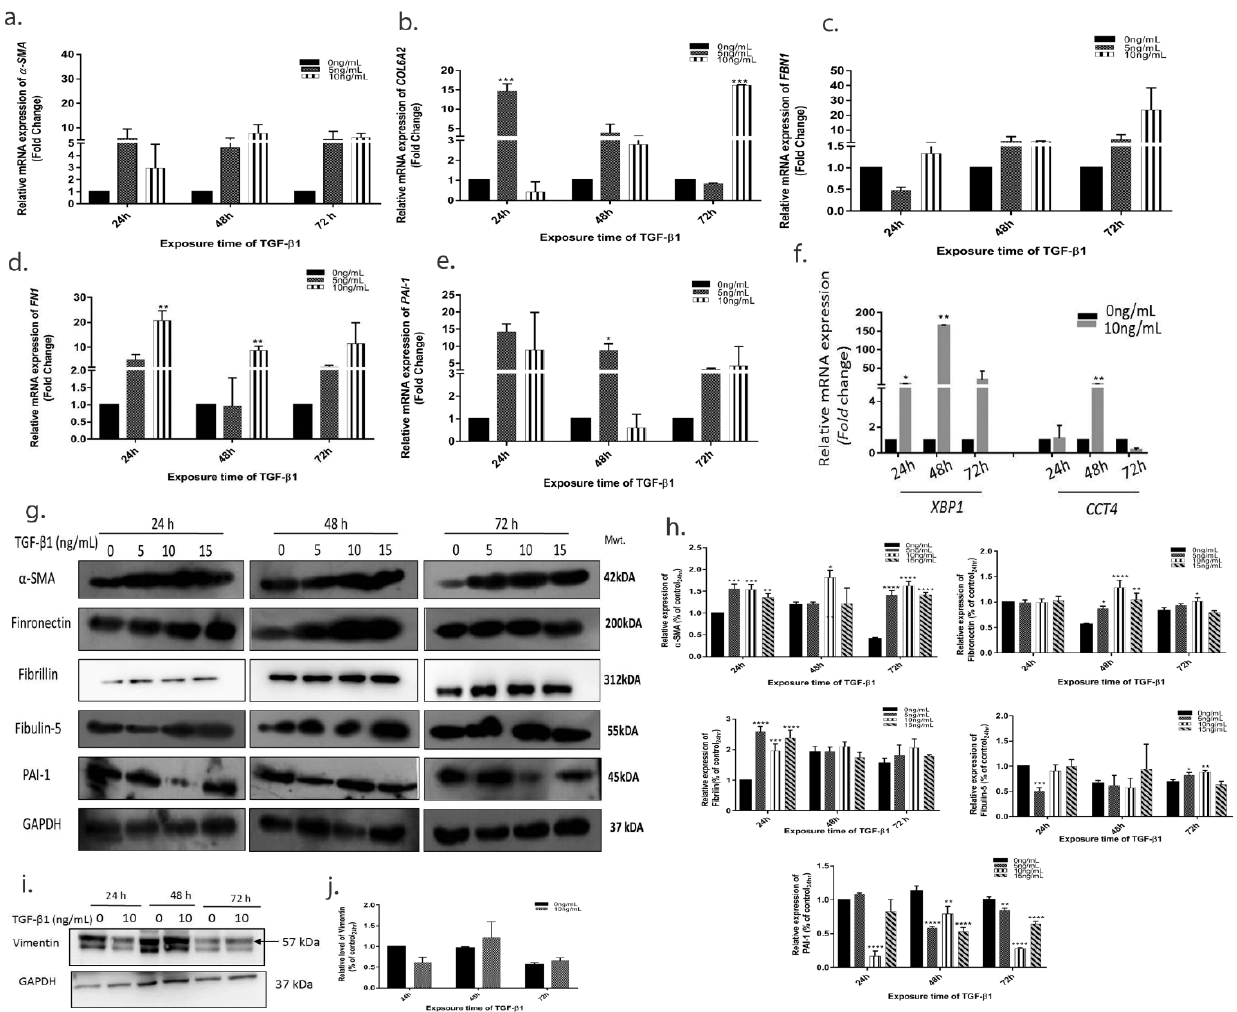
Figure 3. TGF- β 1 induces expression of pro-fibrotic molecules . Relative mRNA expression of ( a ) α -SMA ( b ) COL6A2 ( c ) Fibrillin ( d ) Fibronectin ( e ) PAI-1 ( f ) UPR genes XBP1 and CCT4 ( g ) Protein expression of pro-fibrotic molecules after TGF- β 1 treatment with densitometry analysis using ImageJ ( h ). ( i ) Vimentin expression after 10 ng/mL TGF- β 1 treatment and densitometry analysis ( j ). The error bars represent standard deviation (* p < 0.05, ** p < 0.01, *** p < 0.001, **** p < 0.0001, by one way ANOVA).